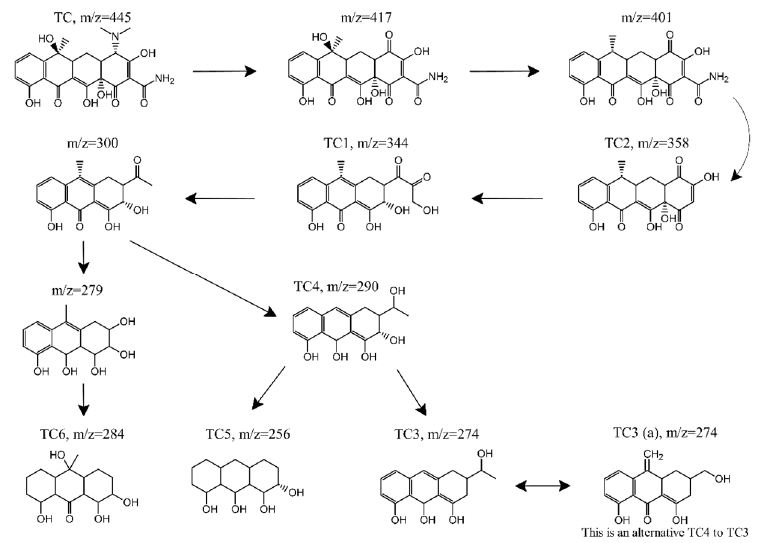
Figure 9. A possible TC degradation pathway in the Fe 3 O 4 /PS system.